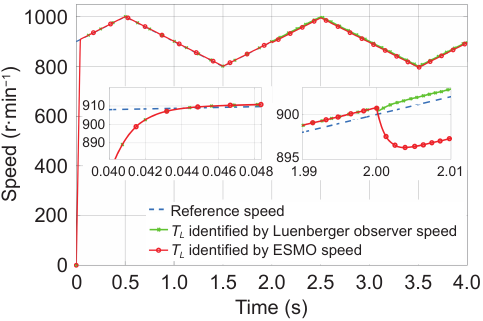
Fig. 18 Waveform of speed for T observer and